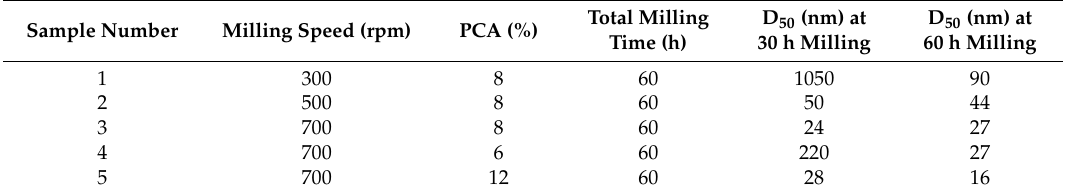
Table 1. The ball milling parameters for different samples (PCA: process control